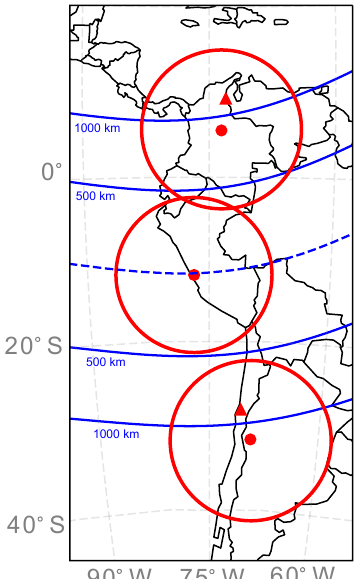
Figure 1. A map of western South America showing the location of the Villa de Leyva (top), Jicamarca (middle), and El Leoncito (bot- tom) ASIs as red dots. The red circles around the dots are the fields of view for an airglow layer at 250km and a zenith angle of 80 ◦ . The red triangle in the Villa de Leyva field of view is the conjugate location of the El Leoncito ASI. The red triangle in the El Leoncito field of view is the conjugate location of the Villa de Leyva ASI. The blue dotted line is the magnetic equator and the solid blue lines are lines of constant magnetic apex